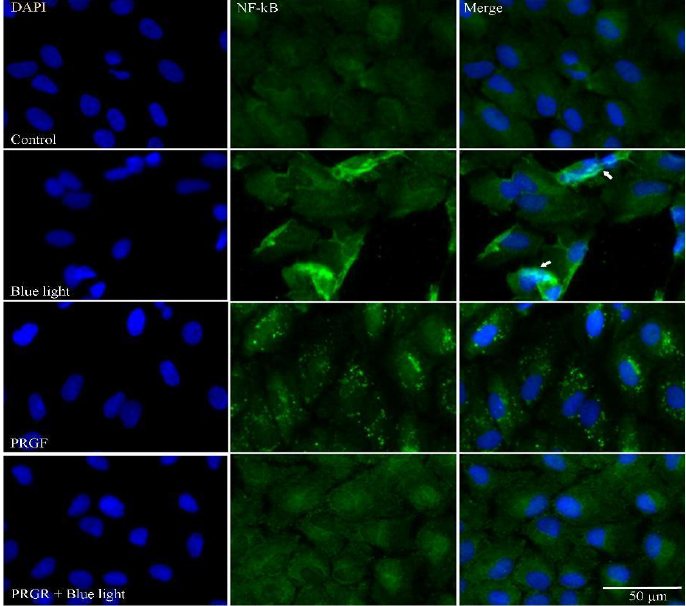
Figure 3. Immunofluorescence staining of NF-kB (green) and nucleus (DAPI, blue). Results indicate the increased presence of NF-kB in the cell nucleus in response to blue light. Treatment with PRGF alone led to a dotted pattern of NF-kB around the nucleus. White arrows point to NF-kB in the nucleus. Scale bar 50 µm ( n = 4).